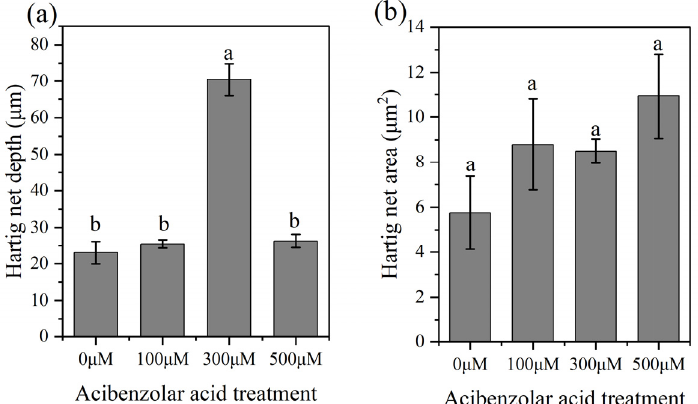
Figure 8. Effects of acibenzolar acid treatment on Hartig net development. ( a ) Hartig net depth; ( b ) Hartig net area. Bars represent means ± the SE, n = 5; different letters above bars indicate significant differences between treatments at p < 0.05.